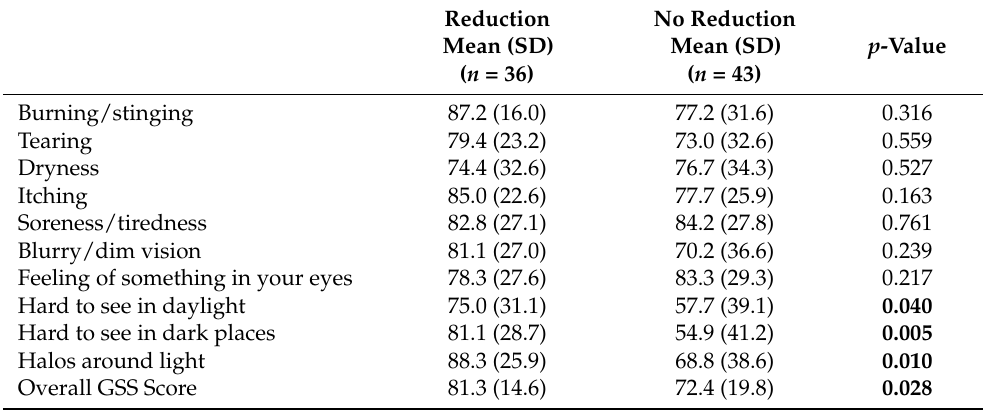
Table 2. Glaucoma Symptom Score (GSS) results. Scores of all single items are depicted and separated by the reduction in eye medication. SD: Standard Deviation.